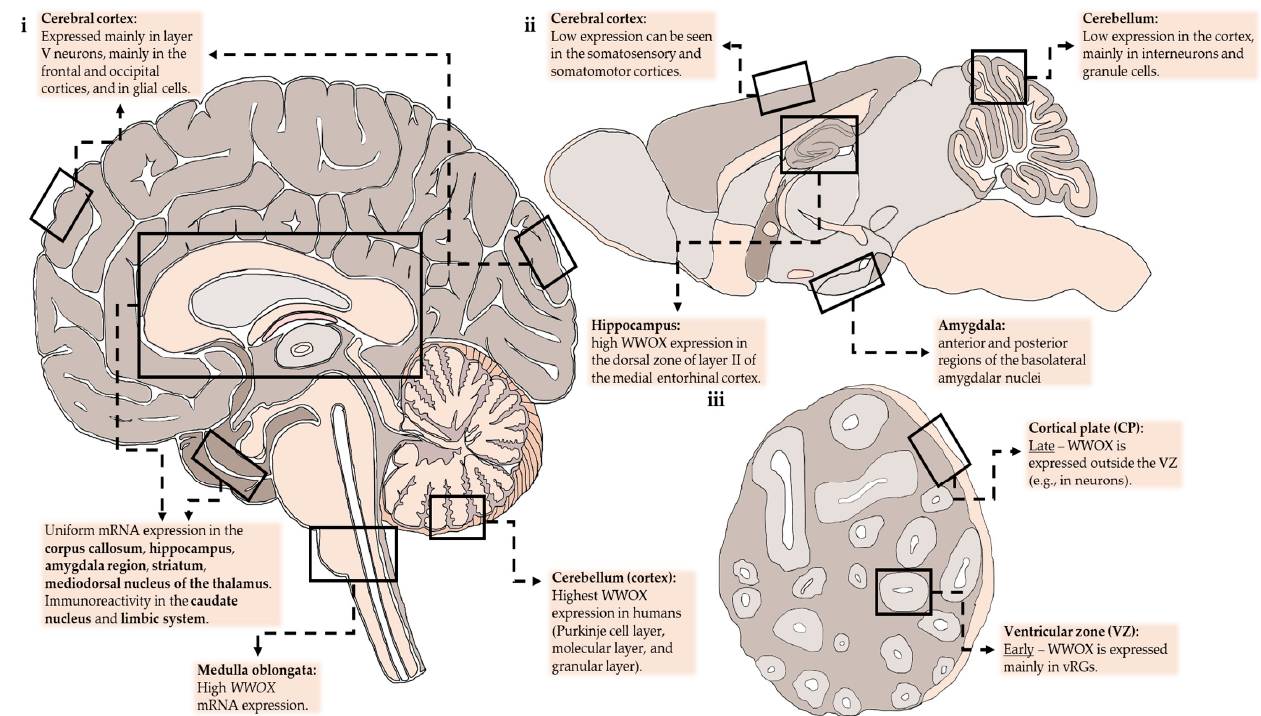
Figure 1. Anatomical regions with a moderate-high expression of WWOX demonstrated schematically in sections of the adult human brain ( i ), adult mice brain ( ii ), and brain organoids ( iii ). vRGs—ventricular radial glia.